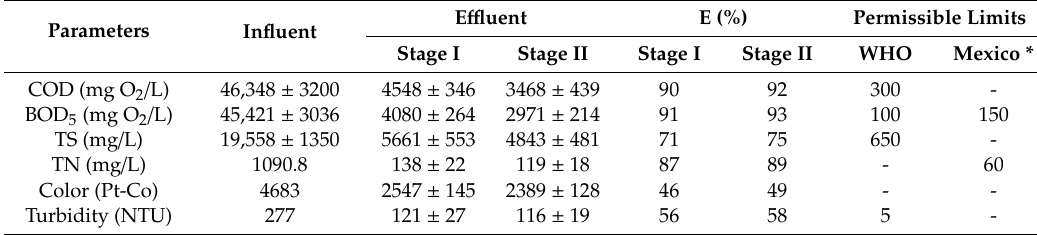
Table 3. General analysis of the influent and e ffl uent of the EGSB